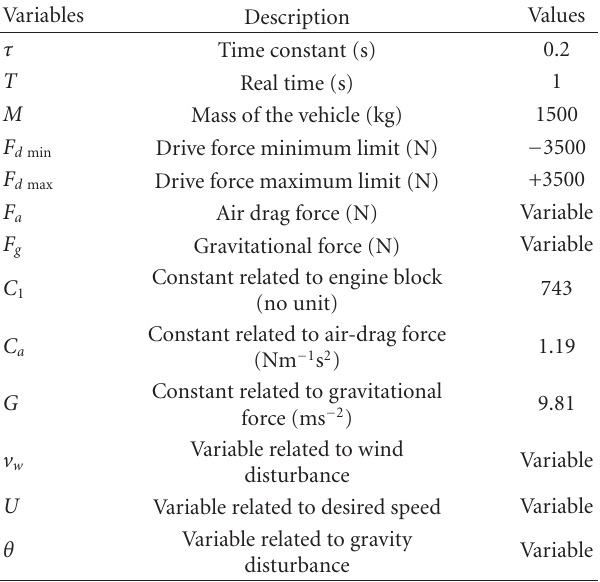
Figure 2. The cruise control system properties and values used are given in Table